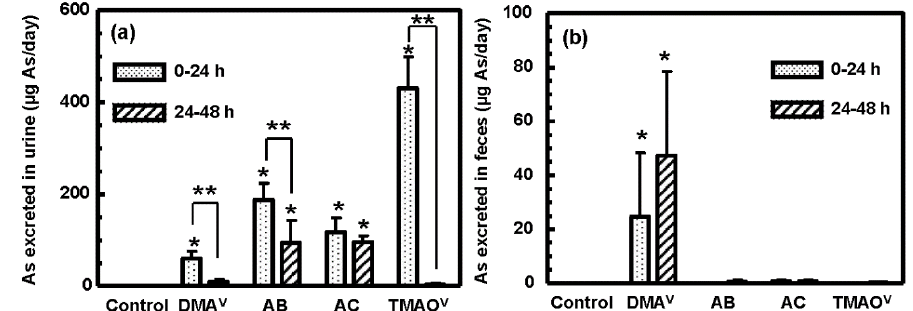
Figure 2. Excretion of arsenic in ( a ) urine and ( b ) feces in rats after oral administration of deionized ‐ distilled water (control), DMA V , AB, AC or TMAO V . Values are presented as the mean ± SD ( n = 4). Single asterisks indicate significant differences ( p < 0.05) compared to the control value; double asterisks indicate significant difference ( p < 0.05) upon comparison between 0–24 h and 24–48 h for a given group.